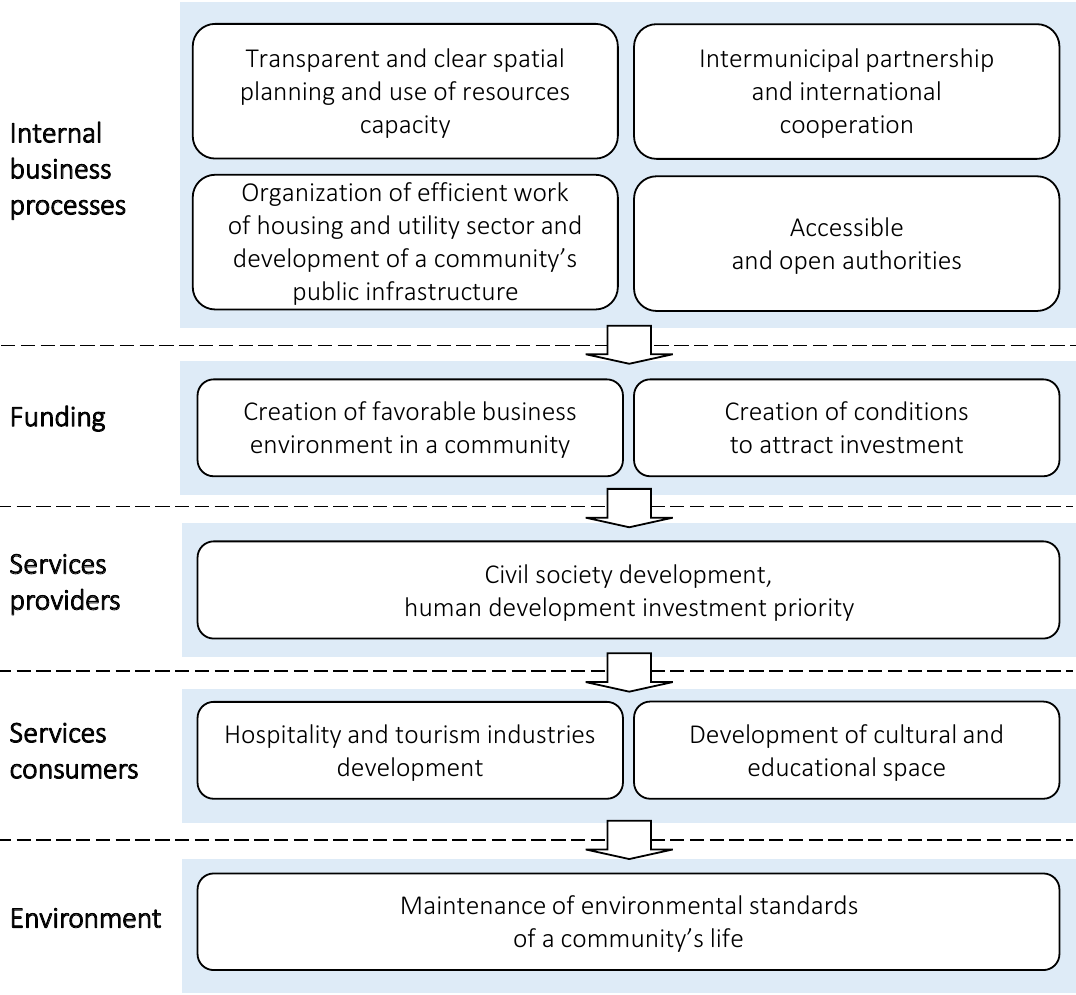
Figure 4. Strategic map for Broshniv-Osadska